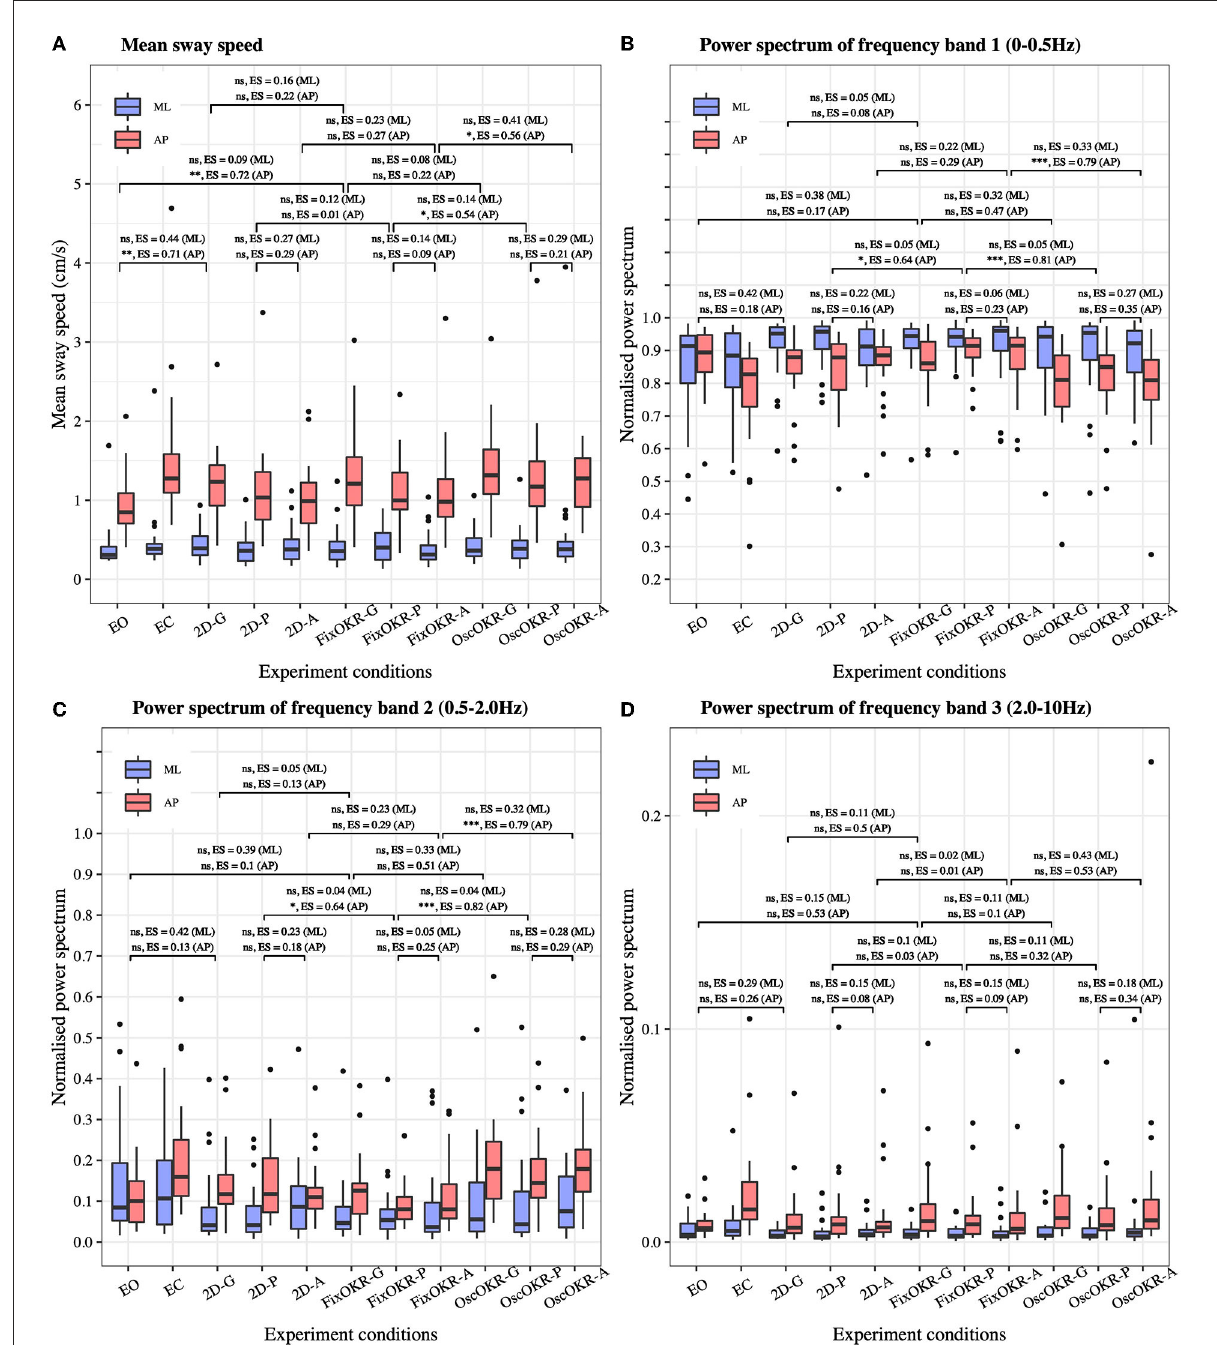
FIGURE3 Postural sway in each test condition. (A) Mean sway speed. (B) Power spectrum of frequency Band 1: 0 − 0.5Hz (related to the visual and vestibular systems). (C) Power spectrum of frequency Band 2: 0.5 − 2.0Hz. (D) Power spectrum of frequency Band 3: 2.0 − 10Hz (related to the proprioceptive system). The effect of Oscillating OKR was observed in mean sway speed and power spectrum of frequency Band 1 and Band 2 in anterior-posterior direction when saccade task was also performed (OscOKR-P and OscOKR-A). The dual-task of posture and the saccade controls could cause more postural sway possibly due to the limited capacity of resources for the two movements. The OKR oscillating at 23 / 60Hz did not influence the proprioceptive function. (-G, Gaze; -P, Pro-saccade; -A, Anti-saccade; OKR, OptoKinetic design-based Room with stripes; FixOKR, Fixed OKR; OscOKR, Oscillating